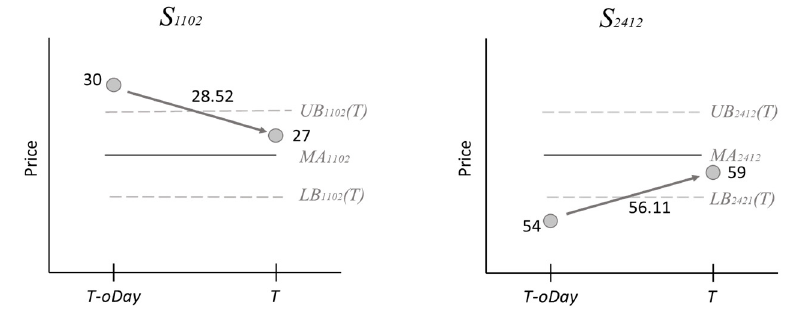
Figure 4. Entry conditions of S 1102 and S 2412